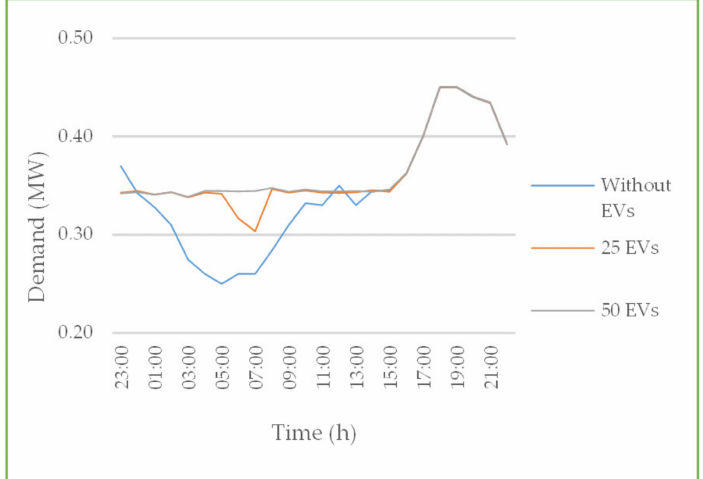
Figure 9. The effect of charging/discharging on LC1 when a fleet of N electric vehicles (EVs) is divided into subgroups of different mobility patterns and used for valley filling or peak shaving: N = 25 and 50 ; k = 0.3 N , m = 0.7 N.